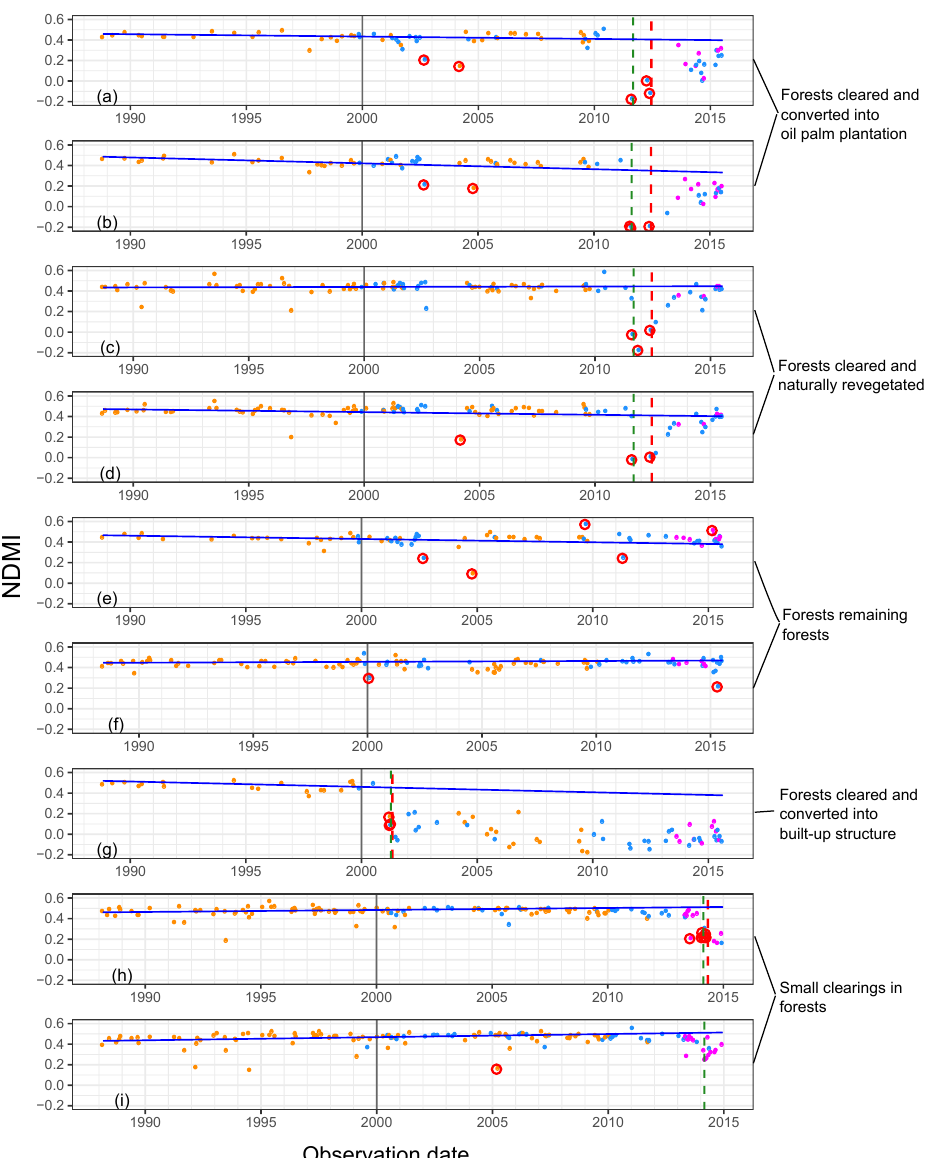
Figure 5. Cloud-free Landsat time series showing different forest change cases, and the application of the deforestation detection algorithm ( k = 4, cons = 3). The forest change cases (as verified in the multitemporal VHSR images, see Figure 6) are: forests cleared and converted into oil palm plantation ( a , b ); forests cleared and naturally revegetated ( c , d ); forests remaining forests, i.e., non-deforestation ( e , f ); forests cleared and converted into settlements (e.g., built-up structure) ( g ); and small clearings in forests ( h , i ). Observations (points) are colored by sensor, i.e., TM in orange, ETM+ in blue, and OLI in magenta. History noise removal is not applied. Vertical black line denotes the start of monitoring, vertical dashed red line denotes algorithm-detected deforestation, red circle marks flagged a potential (not necessarily confirmed) deforestation event, vertical dashed green line denotes the reference date of deforestation, the solid blue line is the ordinary linear regression model fitted to historical